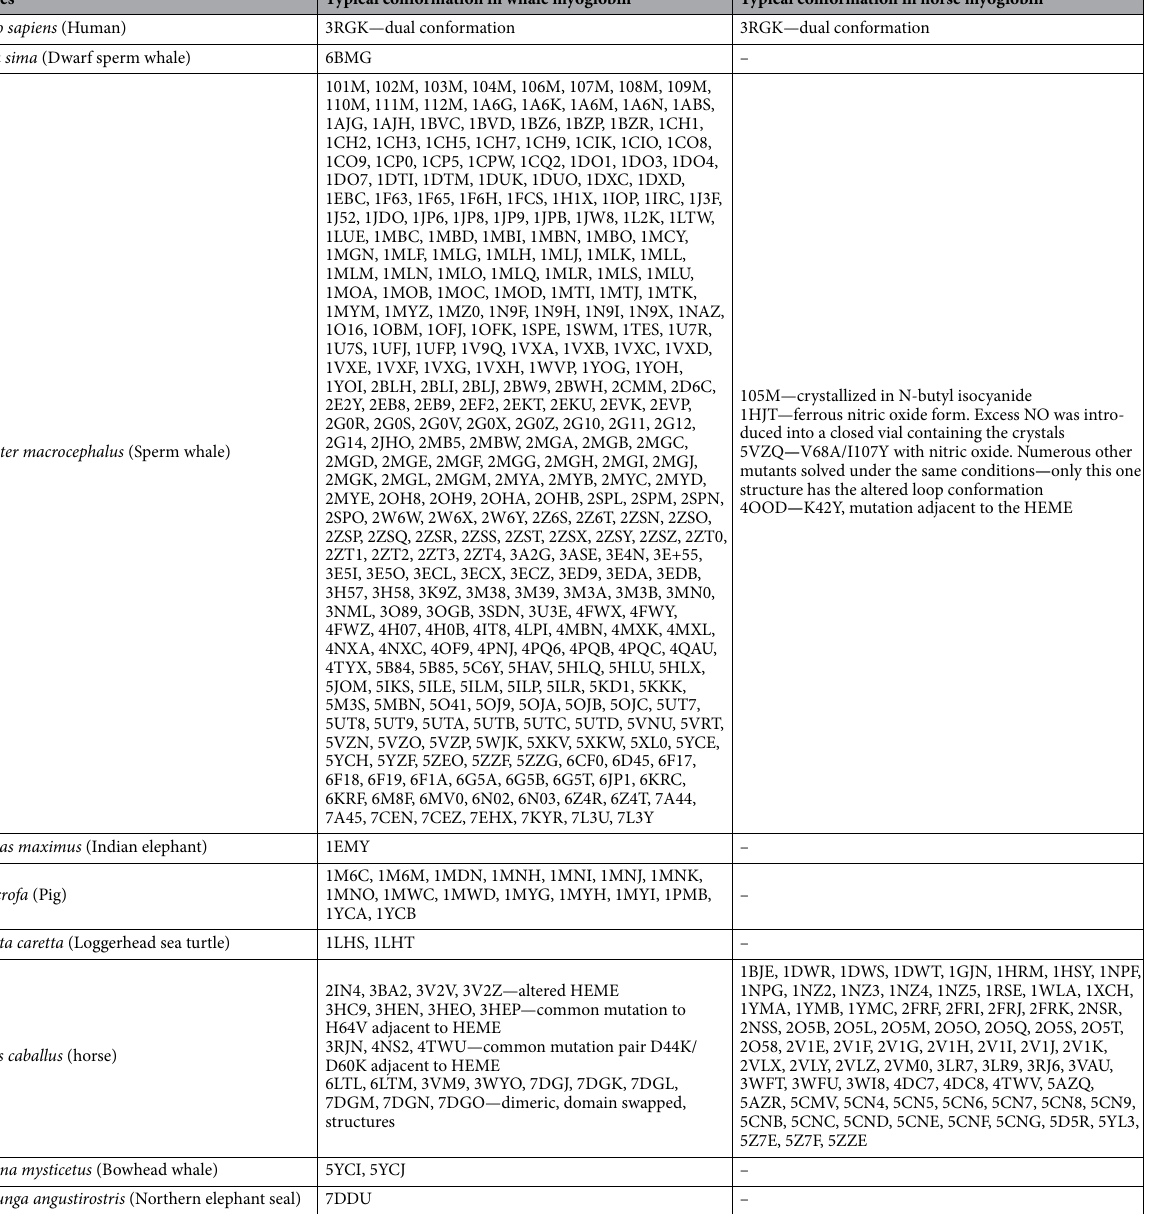
Table 1. Categorization of the turn conformation adopted by myoglobin structures. *Myoglobin from Thunnus thynnus (Atlantic bluefin tuna), Thunnus orientalis (North Pacific bluefin tuna), Thunnus albacares (Yellowfin tuna) are excluded having shorter sequences and specifically in the loop between helices G and H which adopts are entirely different conformation as a result. # Myoglobin from Halichoerus grypus (Gray seal) has a different conformation which cannot be confirmed since the structure is of lower resolution, 2.5 Å, and the density is not available in the